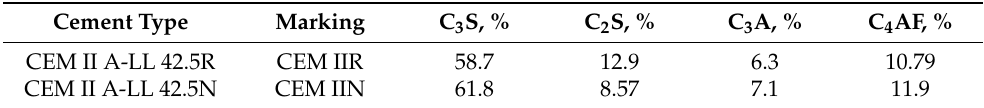
Table 2. Mineralogical composition of